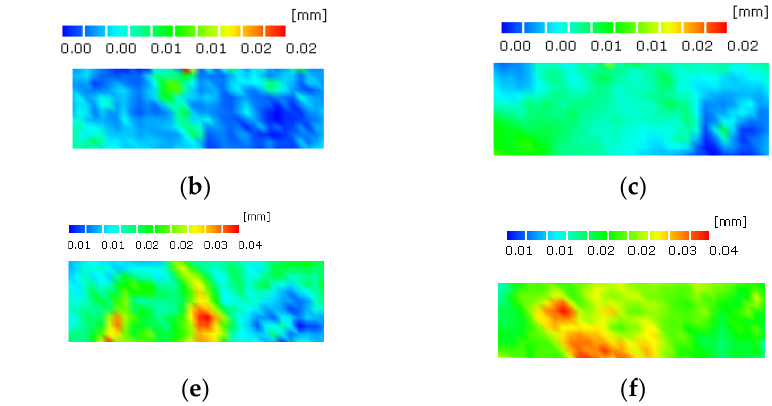
Figure 10. Bending stress-deflection curves and fatigue test results: ( a ) Bending stress- deflection curve; ( b ) Results of fatigue tests for different stress levels.